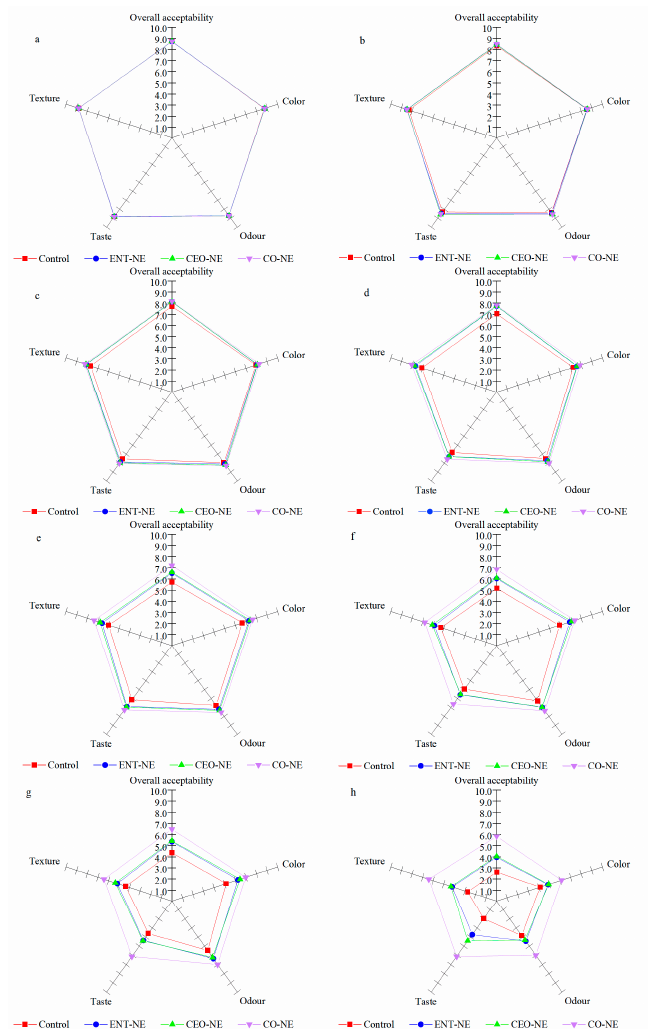
Figure 8. Sensory characteristics of liquid-smoked salmon fillets treated with nanoemulsions con- taining enterocin Gr17 alone (ENT-NE), cinnamaldehyde alone (CEO-NE), enterocin Gr17 and cin- namaldehyde (CO-NE) and no enterocin Gr17/cinnamaldehyde (Control) during storage at 4°C on 0th ( a ), 7th ( b ), 14th ( c ), 21st ( d ), 28th ( e ), 35th ( f ), 42nd ( g ), 49th ( h ) day. The acceptable limit value of sensory properties is 5 for liquid-smoked salmon.